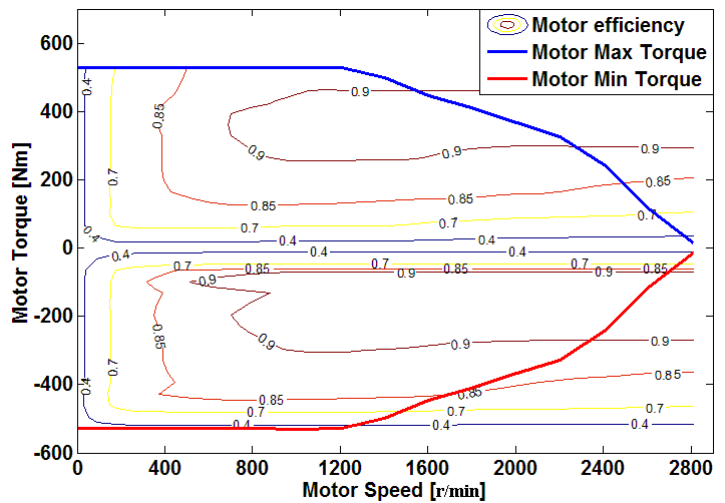
Figure 3. Efficiency diagram of the motor/generator.